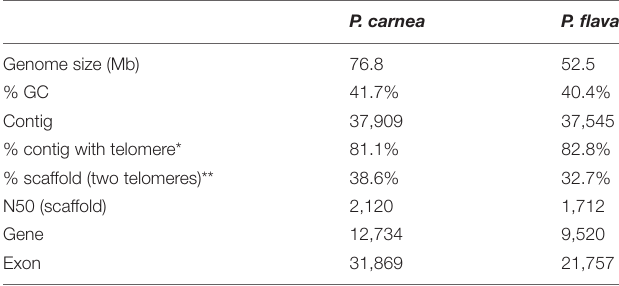
TABLE 1 | MAC genome assembly information for two Pseudokeronopsis